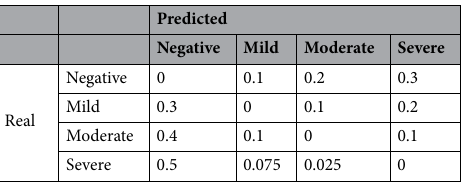
Table 3. Cost matrix M included in the new loss function